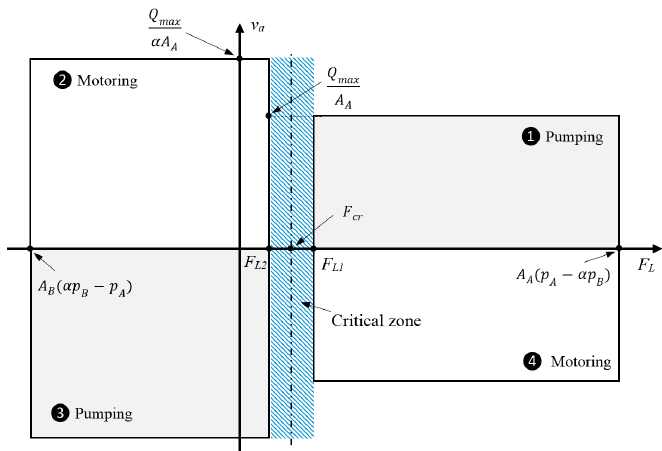
Figure 2 . Critical zone shown by hashed lines in circuits utilizing shuttle valve according to